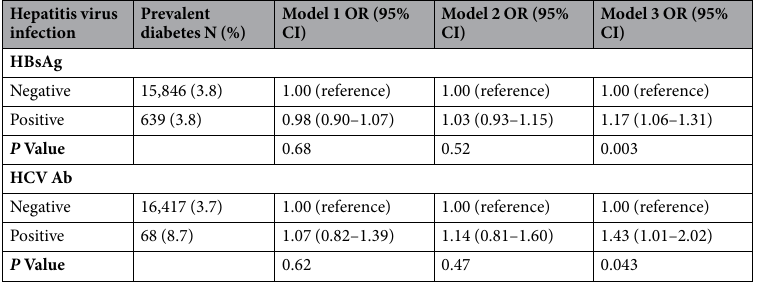
Table 2. Odds ratios for prevalent diabetes by hepatitis virus infection at baseline ( n = 439,708). Model 1: adjusted for age, sex, and center; Model 2: further adjusted for smoking (never, former and current), alcohol (none, moderate and high), education ( ≤ 12 years or > 12 years of education), physical activity ( < 3 times/week and ≥ 3 times/week), and BMI (continuous); Model 3: further adjusted for presence of fatty liver disease.